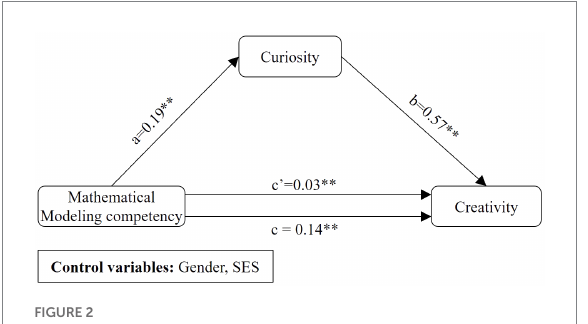
FIGURE 2 Hypothetical indirect pathways between mathematical modeling competency and